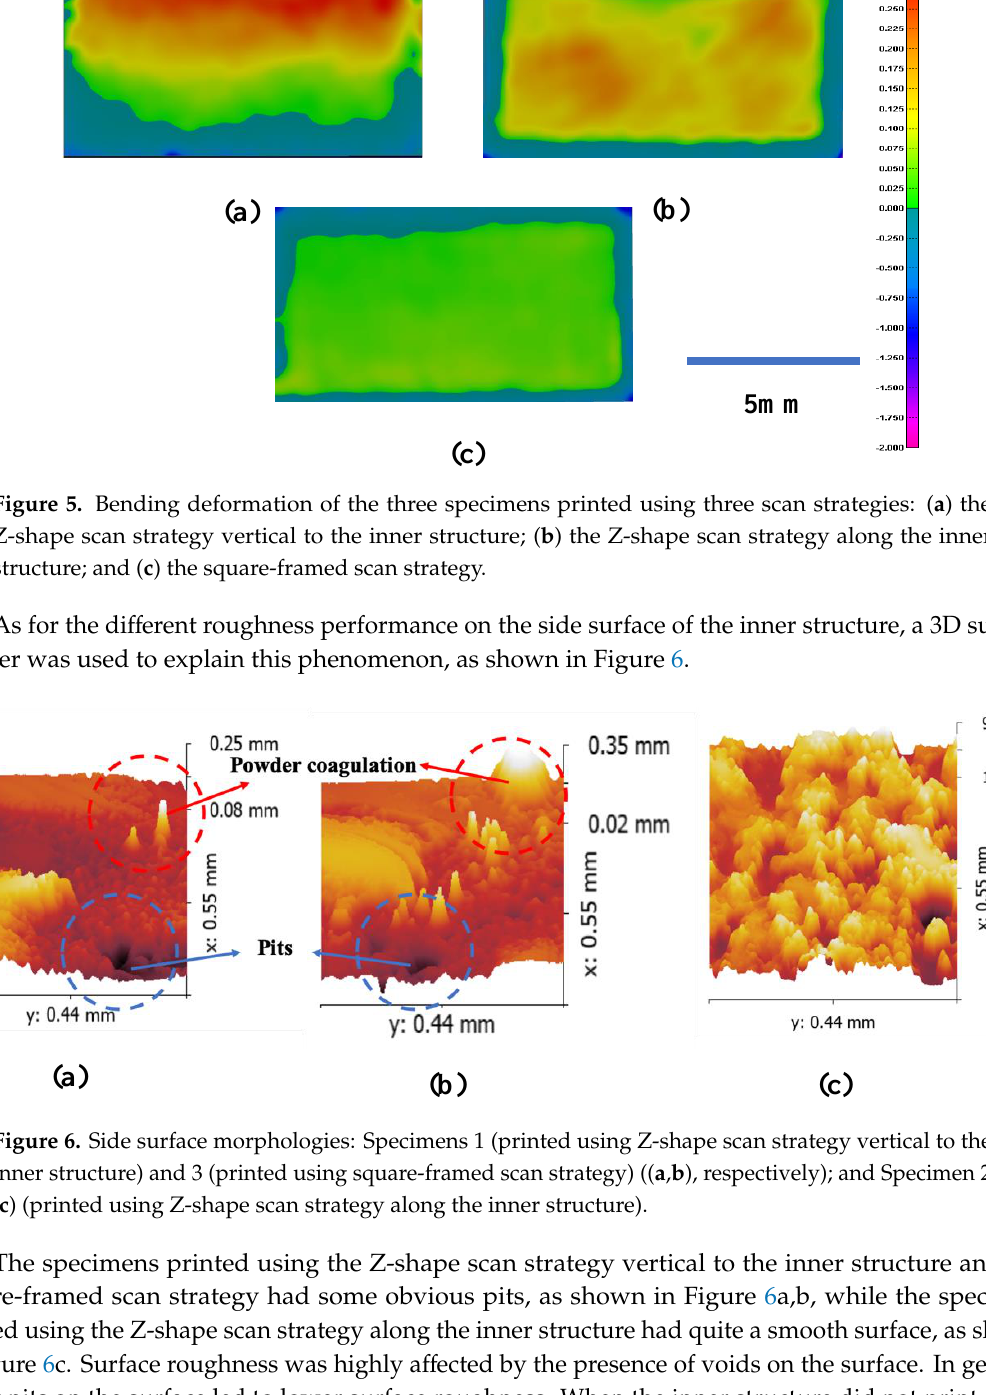
Figure 6. Side surface morphologies: Specimens 1 (printed using Z-shape scan strategy vertical to the inner structure) and 3 (printed using square-framed scan strategy) (( a ) and ( b ), respectively); and Specimen 2 ( c ) (printed using Z-shape scan strategy along the inner structure).